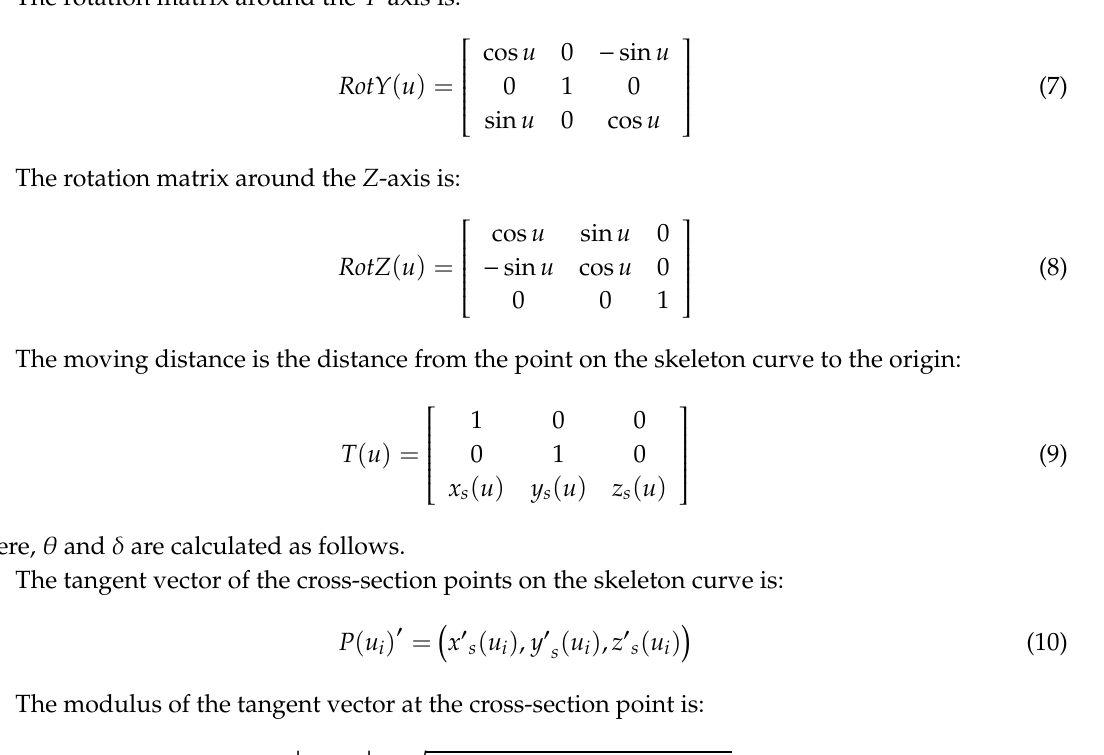
Figure 11. Vector transformation: ( a ) Y -axis rotation, ( b ) Z -axis rotation, ( c ) Translation. The transformation of the coordinate axis is realized by matrix transformation.